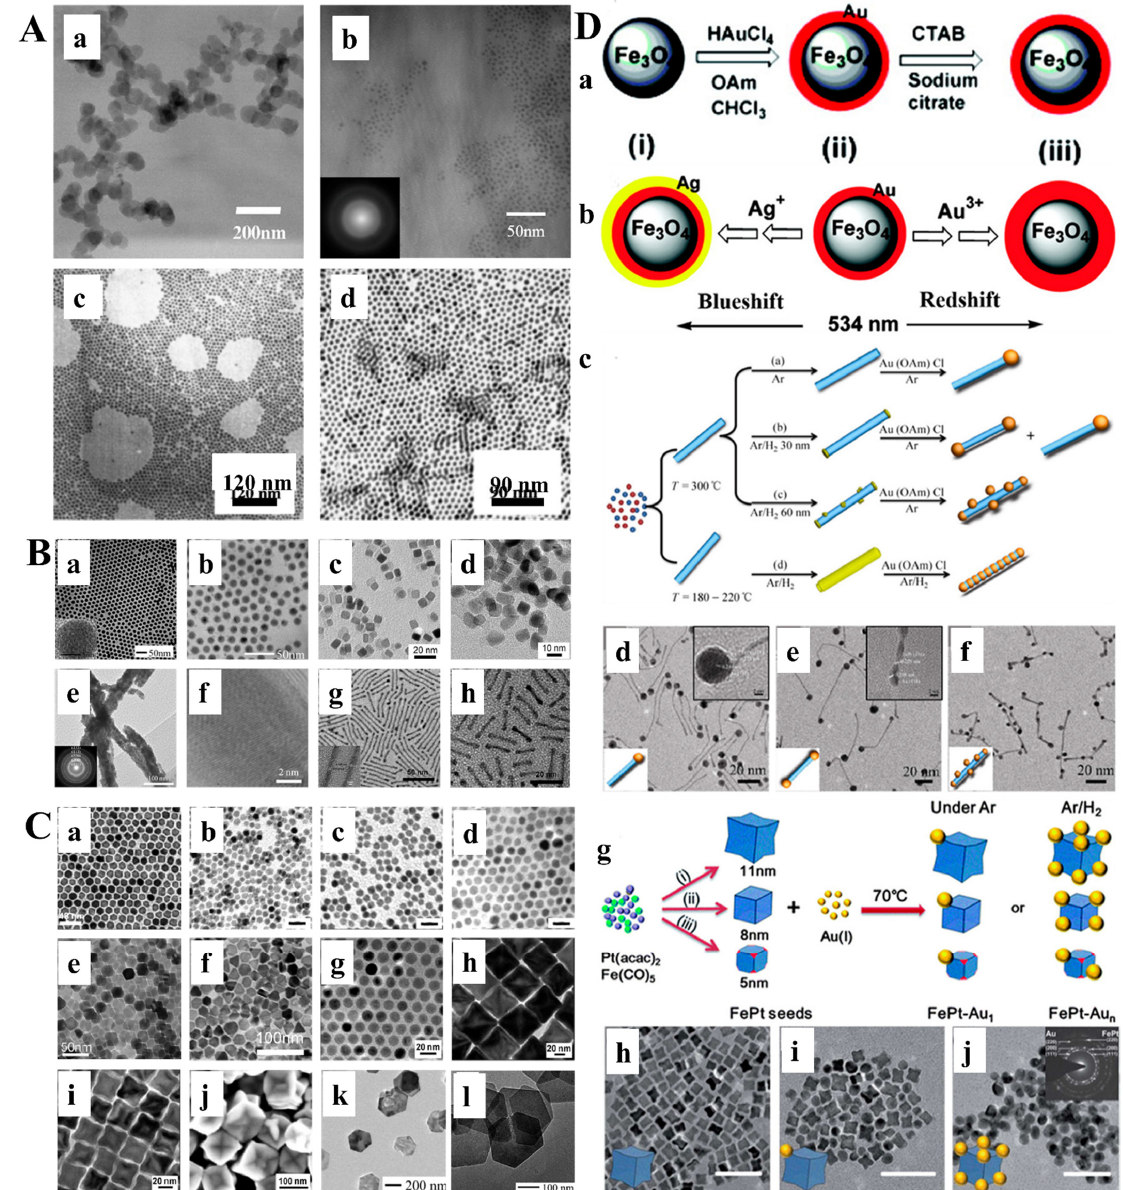
Figure 1. ( A ) Single-component metal nanoparticles. ( a ) TEM image of 65 nm Fe NPs; ( b ) TEM image of 3.7 nm Ni NPs; ( c , d ) TEM images of ( c ) 6 nm and ( d ) 9 nm Co NPs. ( B ) Metal alloy nanopar- ticles. ( a , b ) TEM images of ( a ) 11 nm and ( b ) 16 nm FePd NPs; ( c , d ) TEM images of ( c ) fcc-FePt@Fe 3 O 4 and ( d ) fct-FePt NPs; ( e ) TEM image of FePt NWs and ( f ) HRTEM image after annealing; ( g , h ) TEM images of ( g ) FePt NWs and ( h ) FePt NRs. ( C ) Metal oxide nanoparticles. ( a ) TEM image of 16 nm Fe 3 O 4 NPs; ( b – d ) TEM images of ( b ) 7 ± 0.5 nm, ( c ) 8 ± 0.4 nm, and ( d ) 10 ± 0.8 nm Fe 3 O 4 NPs. The scale bars are 20 nm; ( e ) TEM image of octahedral Fe3O4 NPs; ( f ) TEM image of Fe 3 O 4 nanoprisms; ( g – i ) TEM images of ( g ) 14 nm spherical and ( h ) 32 nm and ( i ) 53 nm truncated octahedral FeO NPs and ( j ) SEM image of truncated octahedral FeO NPs; ( k , l ): TEM images of ( k ) Co(OH) 2 and ( l ) CoO NPLs. ( D ) Heterostructures. ( a , b ) Schematic illustrations of the syntheses of ( a ) Fe 3 O 4 @Au [(i) Fe 3 O 4 ; (ii) Fe 3 O 4 @Au; (iii) hydrophilic Fe3O4@Au] and ( b ) Fe 3 O 4 @Au(@Ag; ( c ) Schematic illustration of